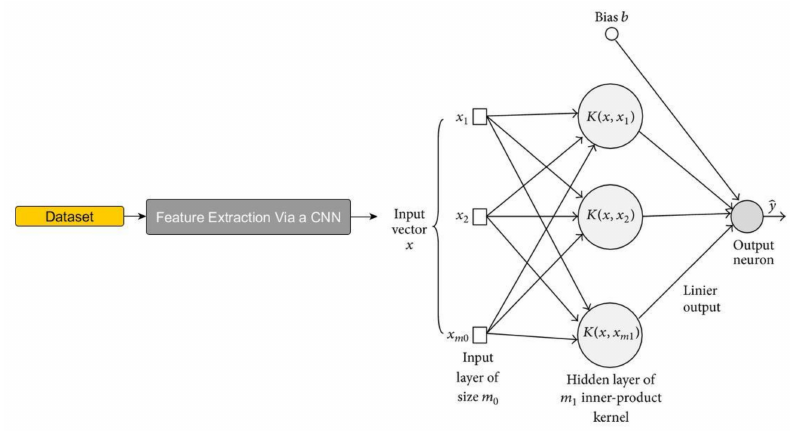
Figure 2. ImprovementintherecognitionbyaddingaSupportVectorMachine(SVM)asthefinalcomponent.